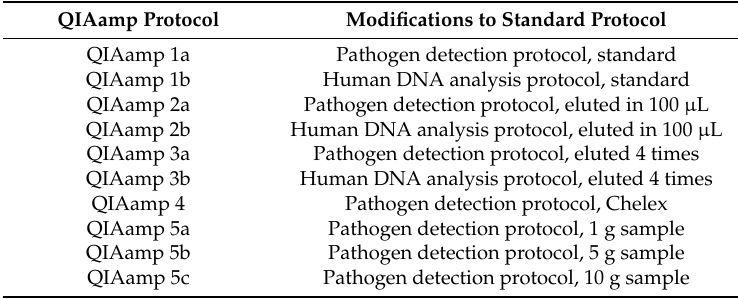
Table 1. QIAamp Fast DNA Stool mini kit protocol